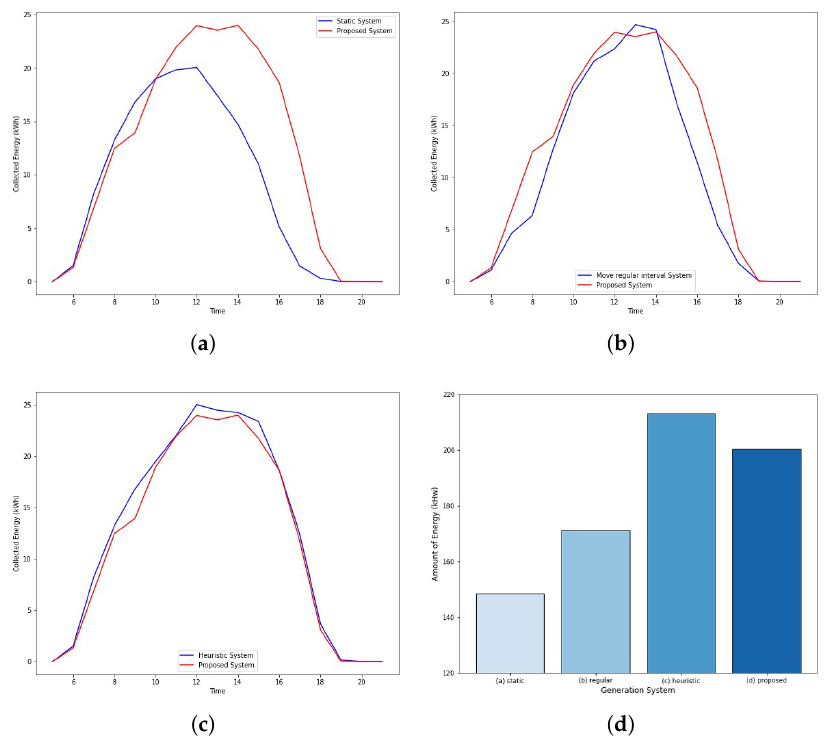
Figure 10. Simulation result. ( a ) Compared with static system; ( b ) Compared with regular system; ( c ) Compared with heuristic system; ( d ) Total amount of generated